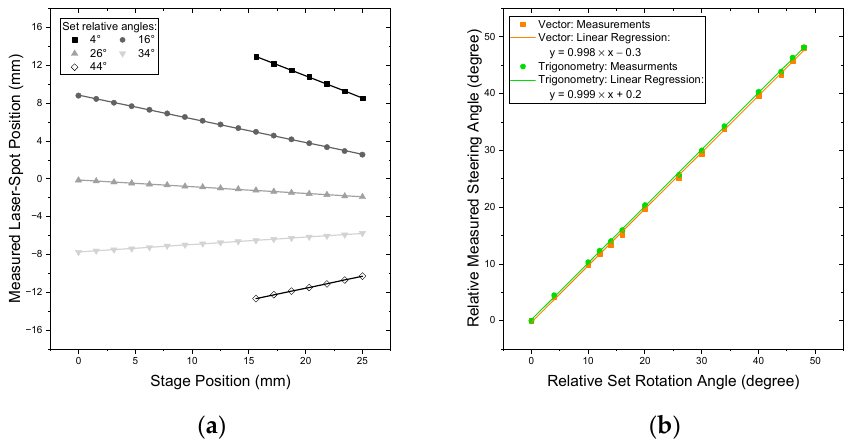
Figure 5. ( a ) Measured horizontal laser spot positions on the screen vs. the Z -axis stage position for several relative set rotation angles; a linear regression for each depicted set angle is included; ( b ) measured angles vs. the set angle including linear regressions for both the vector and trigonometric method of